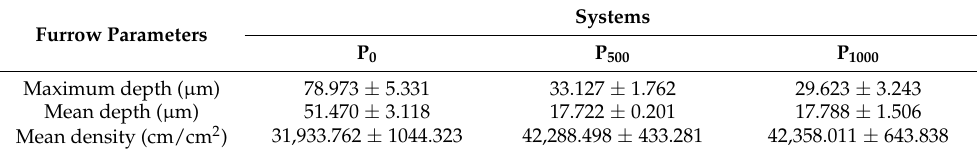
Table 3. Furrow parameters (maximum depth, mean depth, and mean density). Furrow